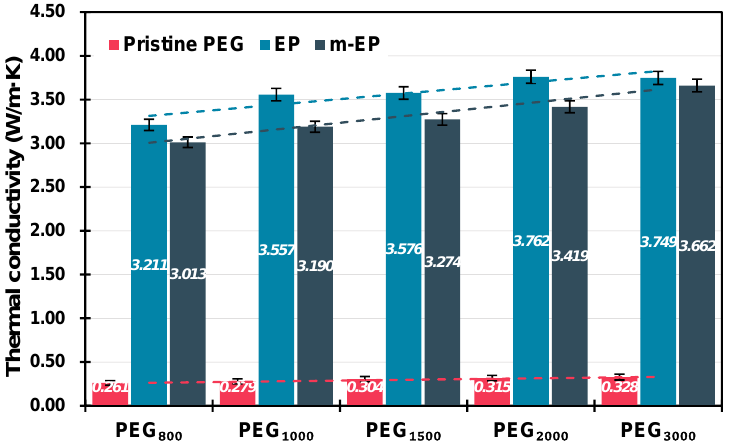
Figure 8. Thermal conductivity of PEGs, EGs, and m ‐ EGs at the same packing